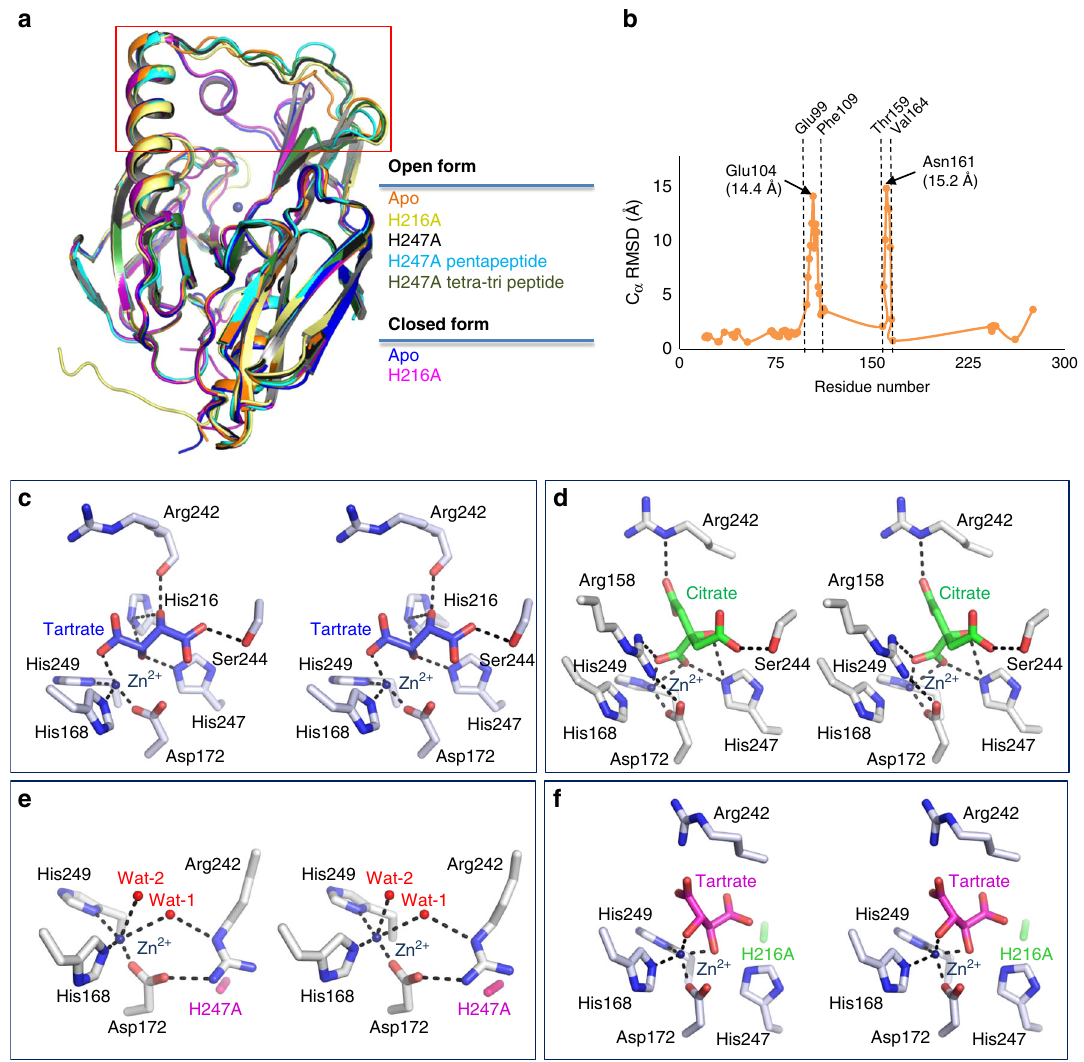
Fig. 2 Structural comparisons and stereo diagrams of Pgp3 active sites. a Structural comparisons of seven crystal structures of Pgp3 with open and closed conformations. Superposition of seven crystal structures of Pgp3 (WT open form in orange, H216A mutant open form in light yellow, H247A mutant in black, H247A mutant with pentapeptide in light blue, H247A mutant with tetra-tri peptide in dark green, WT closed form in blue, and H216A mutant closed form in pink). b Distance plots between WT Pgp3 in the open form (PDB ID: 6JMX) and corresponding C α positions of WT Pgp3 in the closed form (PDB ID: 6JMY). c – f Stereo diagrams of WT Pgp3 active sites around c tartrate (light blue) and d citrate (green) molecules. Tetrahedral coordination of Zn 2 + and hydrogen bonds is represented by black dotted lines, whereas red spheres represent water molecules. e Stereo diagrams of H247A mutant (open form). The position of H247A mutation is shown in pink. f Stereo diagrams of H216A mutant in complex with tartrate (magenta). The position of H216A mutation is shown in